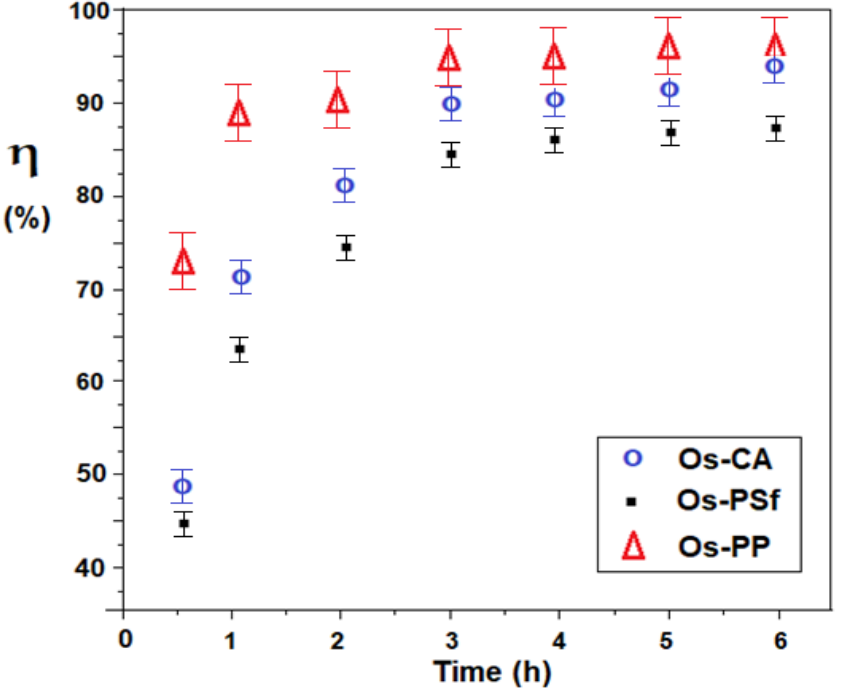
Figure 18. Variation of the conversion of 5 – nitrobenzimidazol to 5 – aminobenzimidazol depending on the operating time, for osmium – polymer (Os – P) prepared membranes.